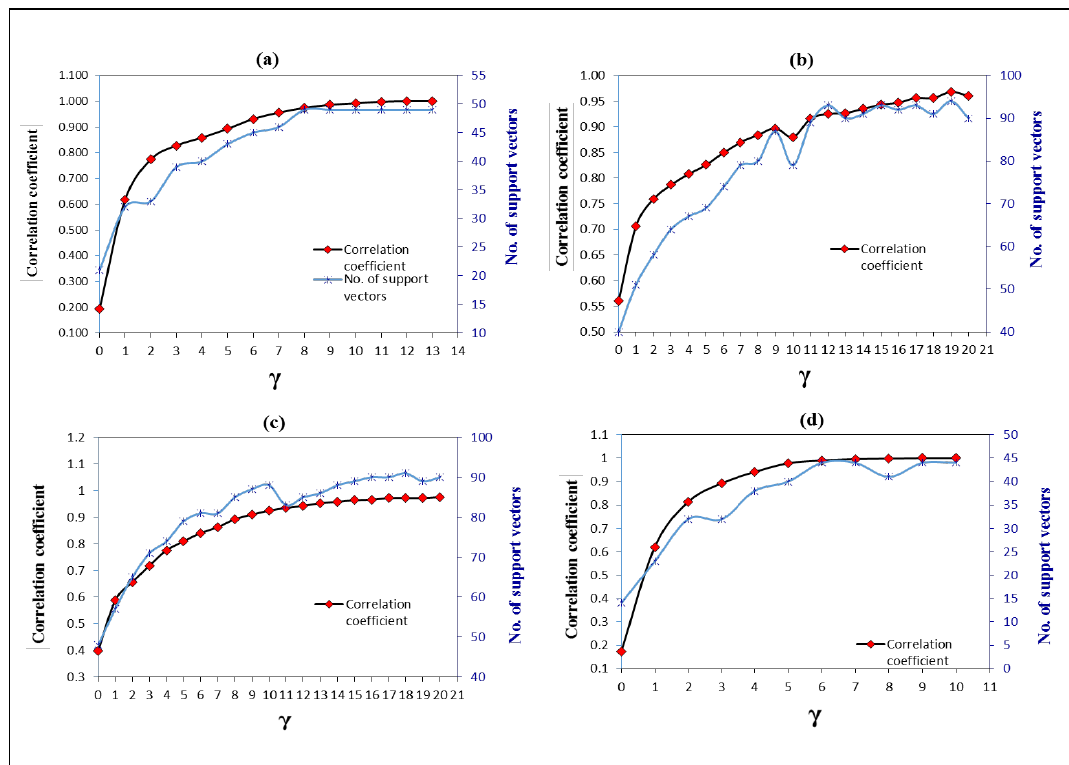
Figure 4. The result of various capacity parameter Gamma, of SVM for ( a ) station 1; ( b ) station 2; ( c ) station 3; and ( d ) station 4.